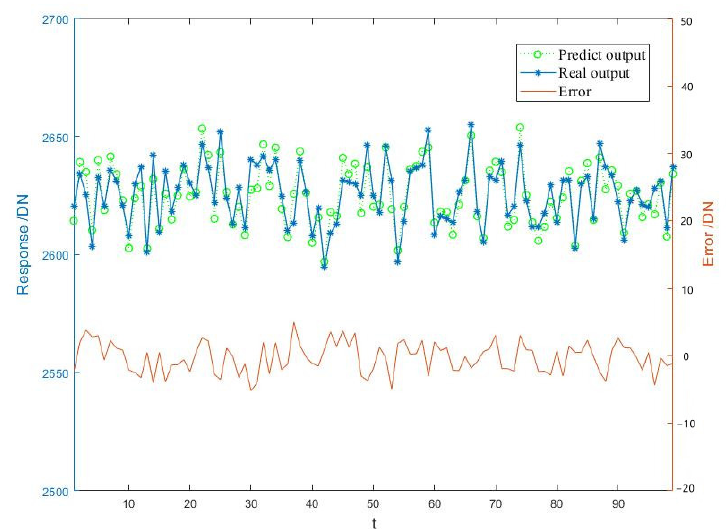
Figure 10. Comparison of predicted and actual dark level correction values.